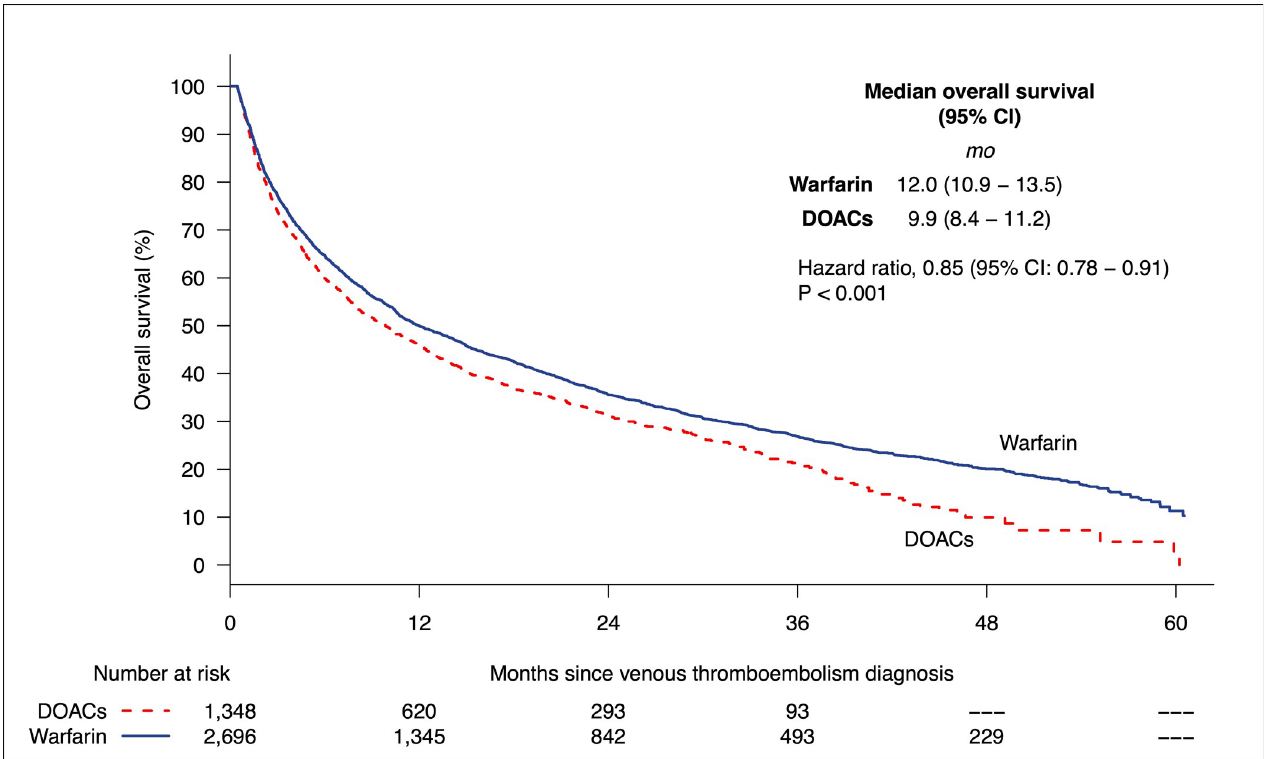
Fig 1. Kaplan–Meier curves of overall survival in DOAC-treated patients (dashed line) versus warfarin-treated patients (solid line) with cancer- associated VTE. C AU : AbbreviationlistshavebeencompiledforthoseusedthroughoutFigs 1 (cid:0) 3 : Pleaseverifythatallentriesarecorrect : I, confidence interval; DOAC, direct oral anticoagulant; VTE, venous thromboembolism.